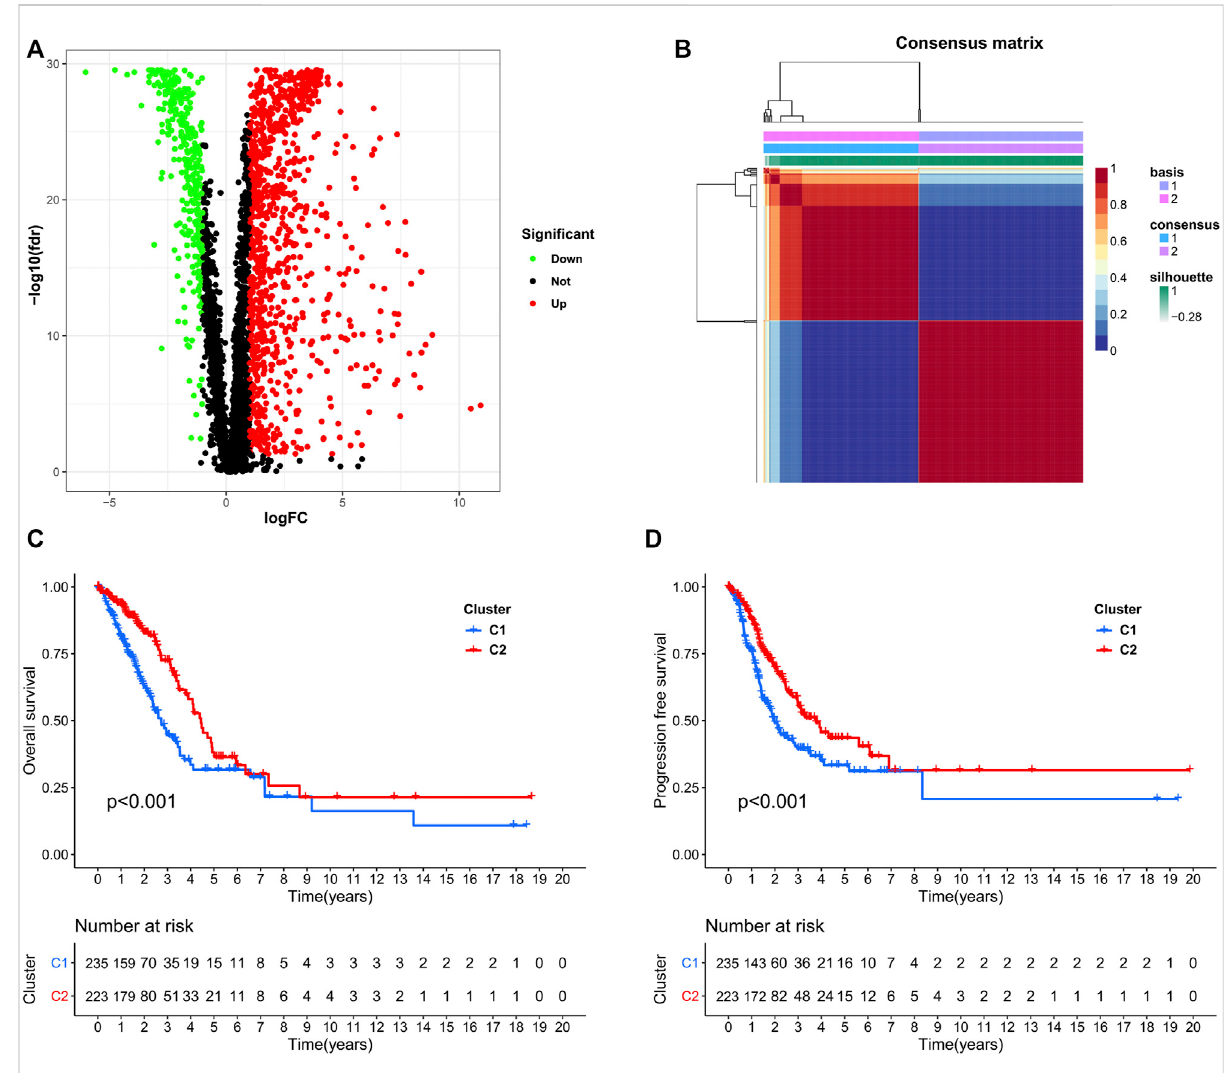
FIGURE 1 Identi fi cationofNSCLCsubclassesusingNMFconsensusclustering. (A) ,AvolcanomapofdifferentiallyexpressedgenesrelatedtotheTME. (B) , NMF clustering using microenvironment-related genes. (C,D) , Survival analysis of patients in Clusters one and